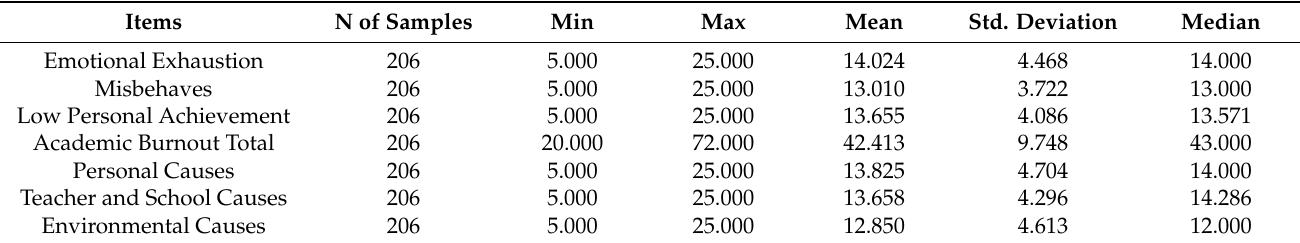
Table 2. Basic statistics of each subscale.